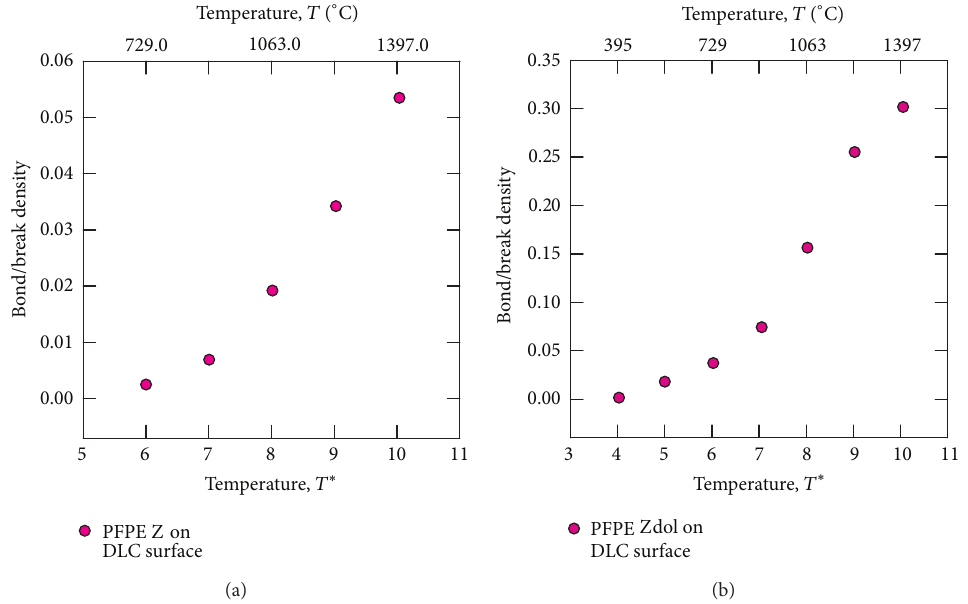
Figure 10: Effects of temperature on the bond/break density: (a) of PFPE Z; (b) of PFPE Zdol on a DLC substrate when the DLC film is compressed into half of its original